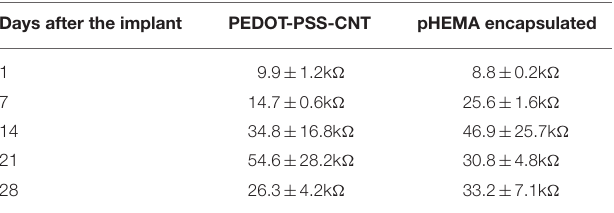
TABLE 4 | Impedance values at 1 kHz of pHEMA-encapsulated and non-encapsulated PEDOT-PSS-CNT coated microspheres. Days after the implant PEDOT-PSS-CNT pHEMA encapsulated 1 9.9 ± 1.2k